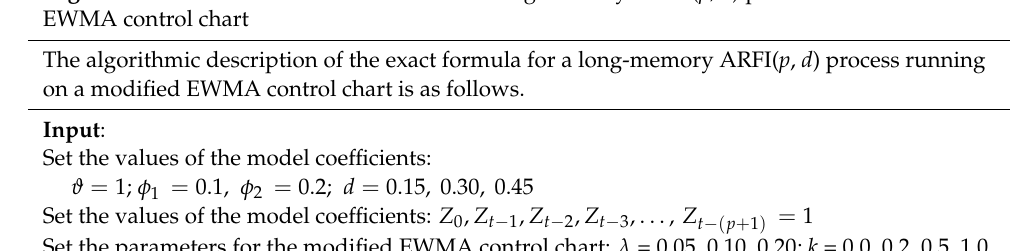
Algorithm 1. The exact formula of ARL for a long-memory ARFI ( p , d ) process on a modified EWMA control